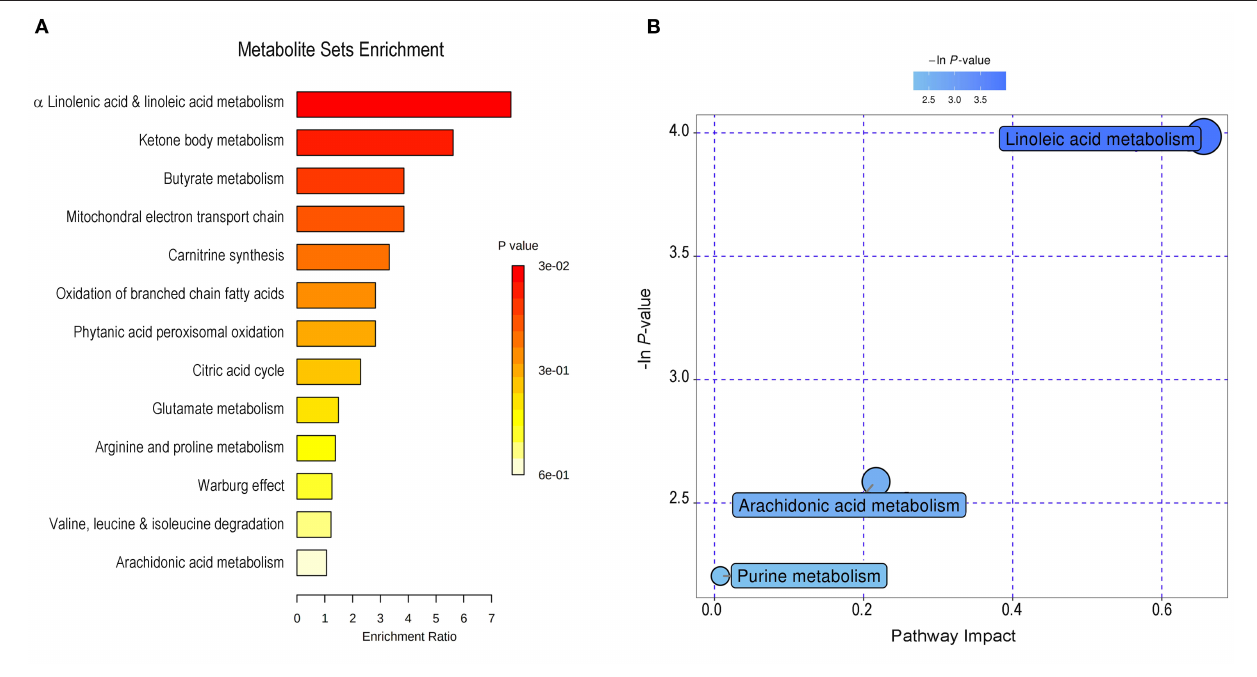
FIGURE 3 | Metabolite set enrichment and pathway analysis of changed metabolites in SLK tear fluids. By MetaboAnalyst (http://www.metaboanalyst.ca), 50 significantly changed metabolites were subjected to metabolite set enrichment analysis (A) and to pathway analysis (B) . The main involved metabolic processes were noted with varying color according to the significance of each